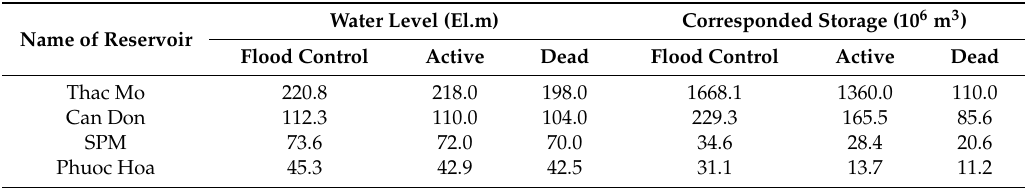
Table 1. Operation features of cascade